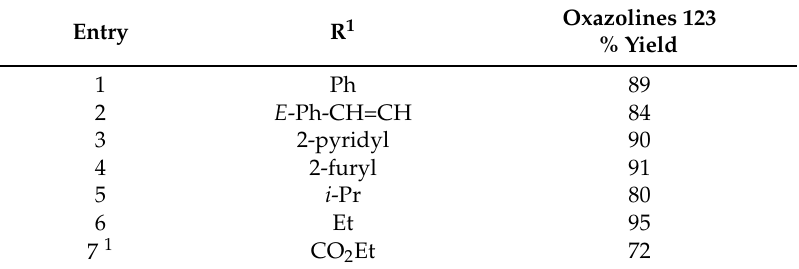
Table 16. Cycloaddition of azomethine ylide 121 to aldehydes 2 (Scheme 30).